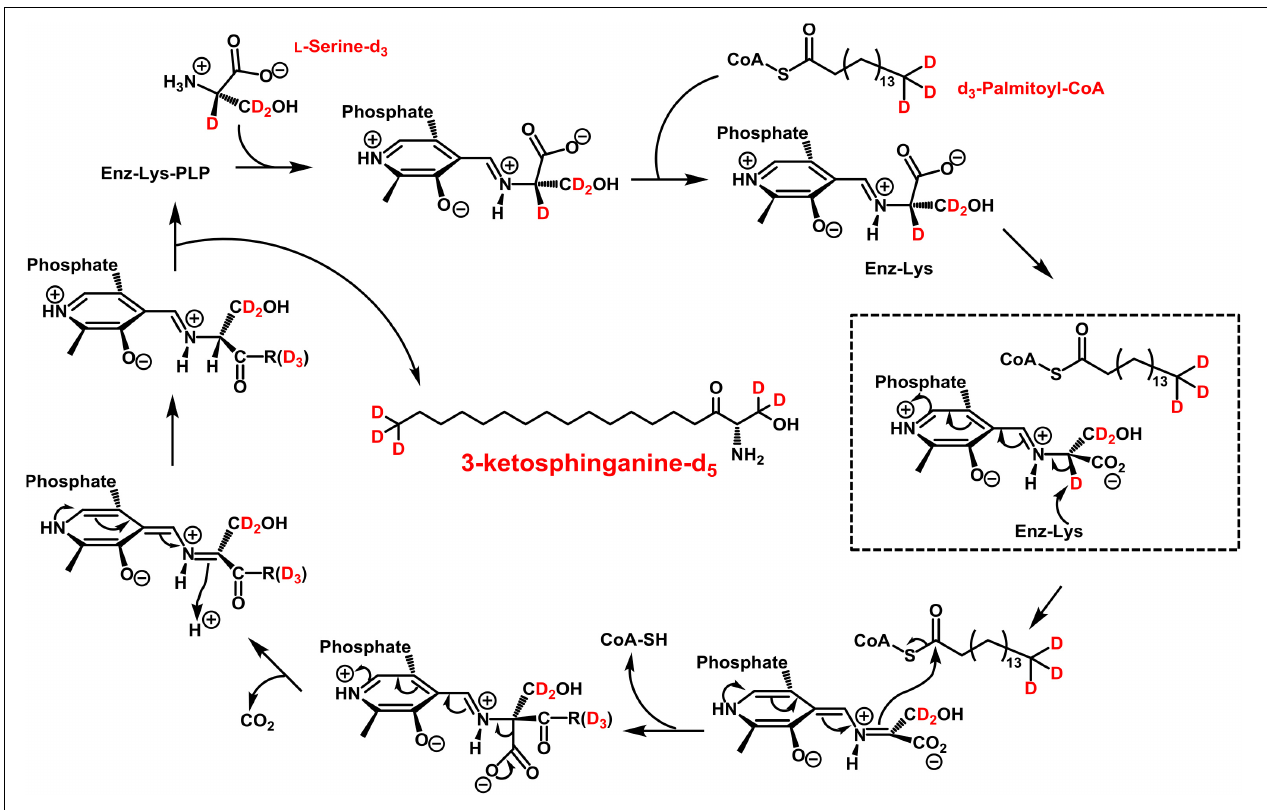
FIGURE 3 | Proposed catalytic cycle for serine palmitoyltransferase (SPT) with d 3 -palmitoyl-CoA and L -serine-d 3 being the substrates. This scheme was modified from A. H. Merrill, Jr. (Merrill, 2011). An internal aldimine (Schiff base) formed between the cofactor pyridoxal 5’-phosphate (PLP) and an active site lysine residue (Enz-Lys-PLP, upper left) is replaced by the external aldimine through the incoming L -serine-d 3 . Binding of d 3 -palmitoyl-CoA results in transfer of serine α -deuterium to an enzymatic lysine residue (dashed box). The reaction proceeds as shown with free CoA, CO 2 , and 3-ketosphinganine-d 5 (3KS-d 5 ) are released as